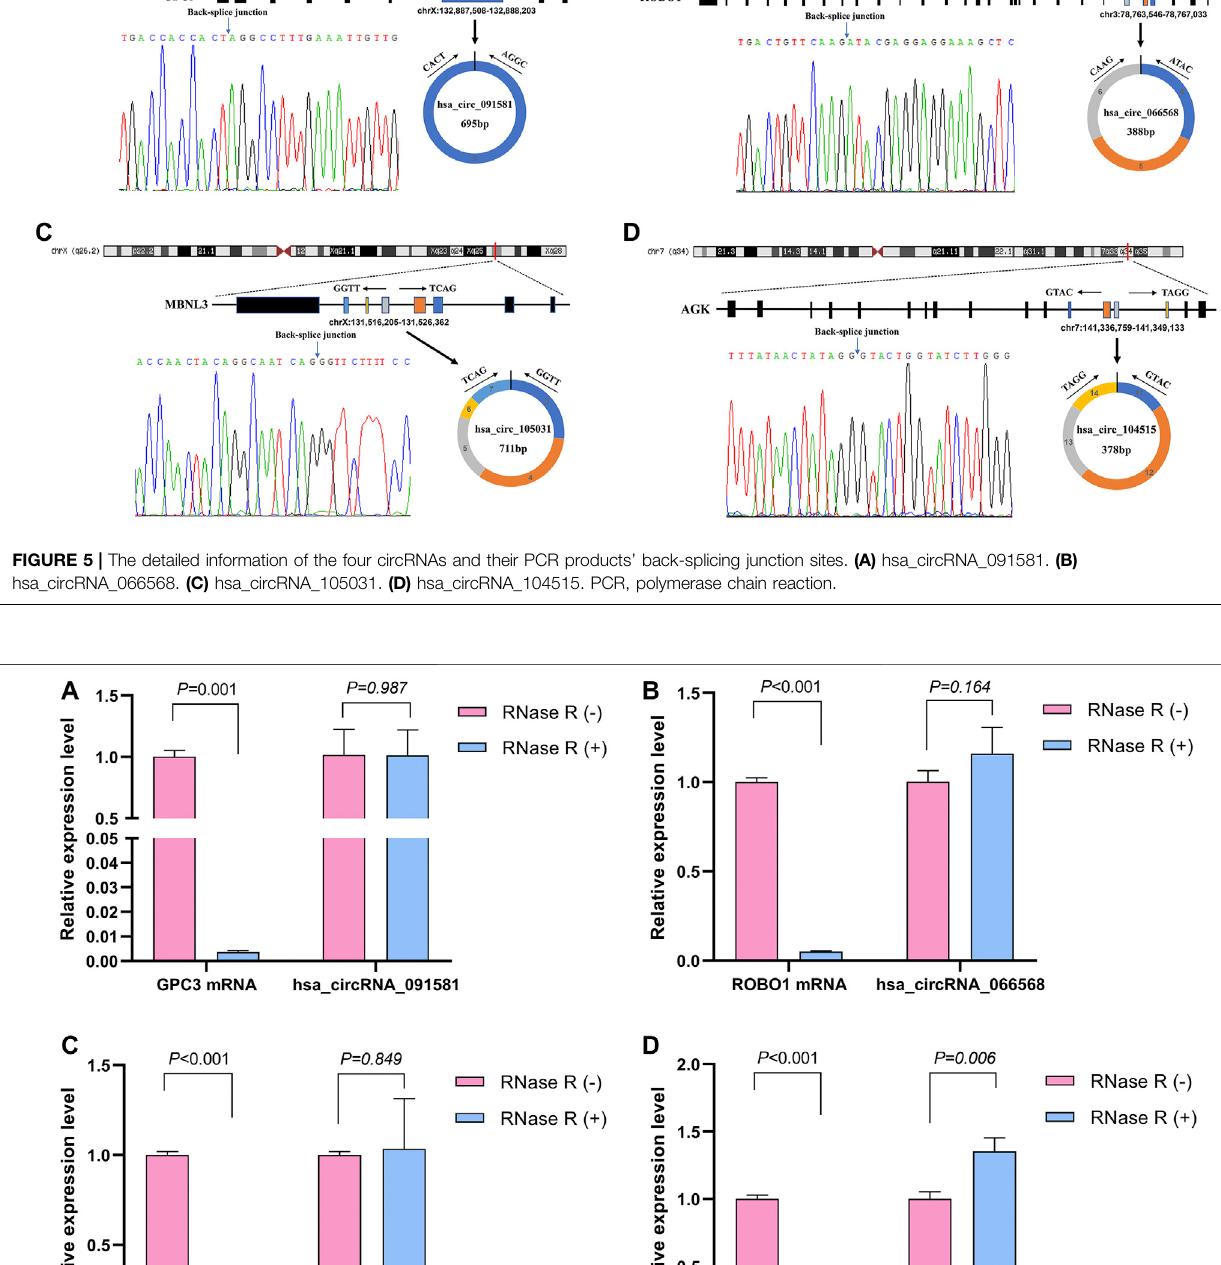
Frontiers in Molecular Biosciences |